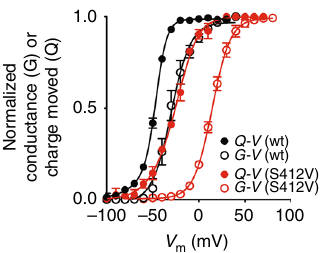
Fig. 6 Putative key residue S412 in the VSD//PD interface in Shaker. The graph shows Q – V curves recorded in nonconductive Shaker, as well as G – V curves from Shaker carrying (red circles) or not (black circles) the mutation S412V, supposedly disruptive of the VSD//PD interface. Q – V curves are plotted as fi lled circles and G – V curves with open circles. Q – V curves were fi tted with a three-state model to obtain V V G – 0 and 1 voltage dependences. V curves were fi tted with a two-state model to get a midpoint V 1/2 . All data points are the average of 4 – 6 independent experiments. The vertical bars are the standard error of the mean. Continuous lines over the data points represent the best fi t of a three-state model for Q – V curves and a two-state model for G – V curves. All V 0 , V 1 , and V 1/2 voltage-dependent